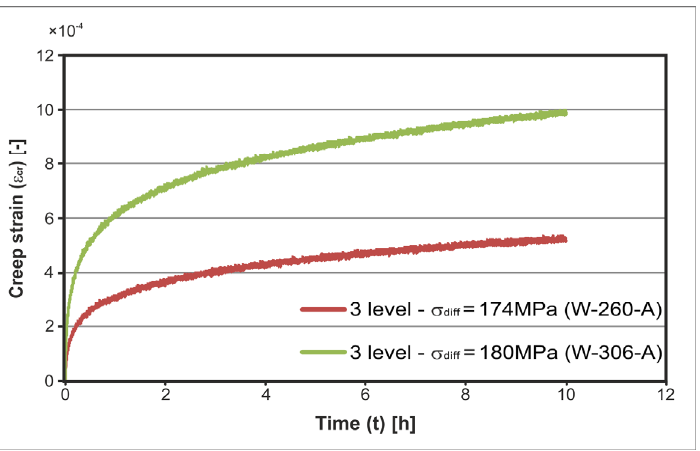
Figure 18. Third-loading creep strain from viscoelastic creep tests for samples W-260-A and